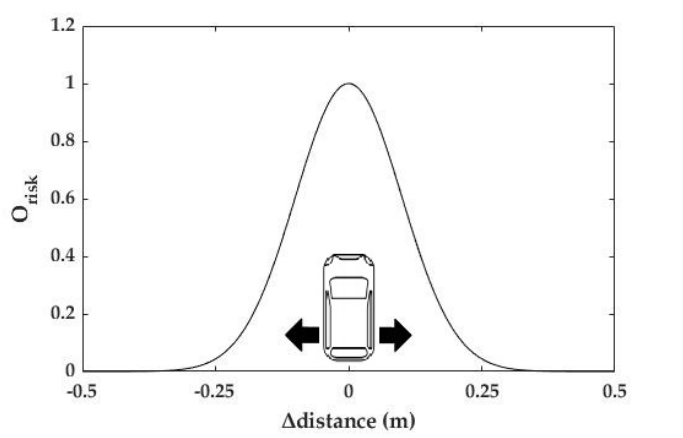
Figure 9. Obstacle-dependent Gaussian concept ( ω = 1 and σ 2 =